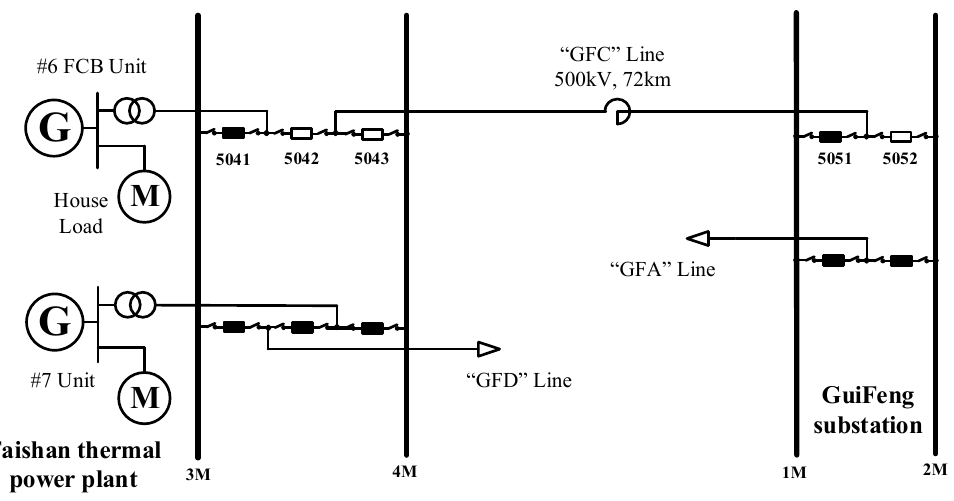
Figure 12. Single line diagram of the field test.